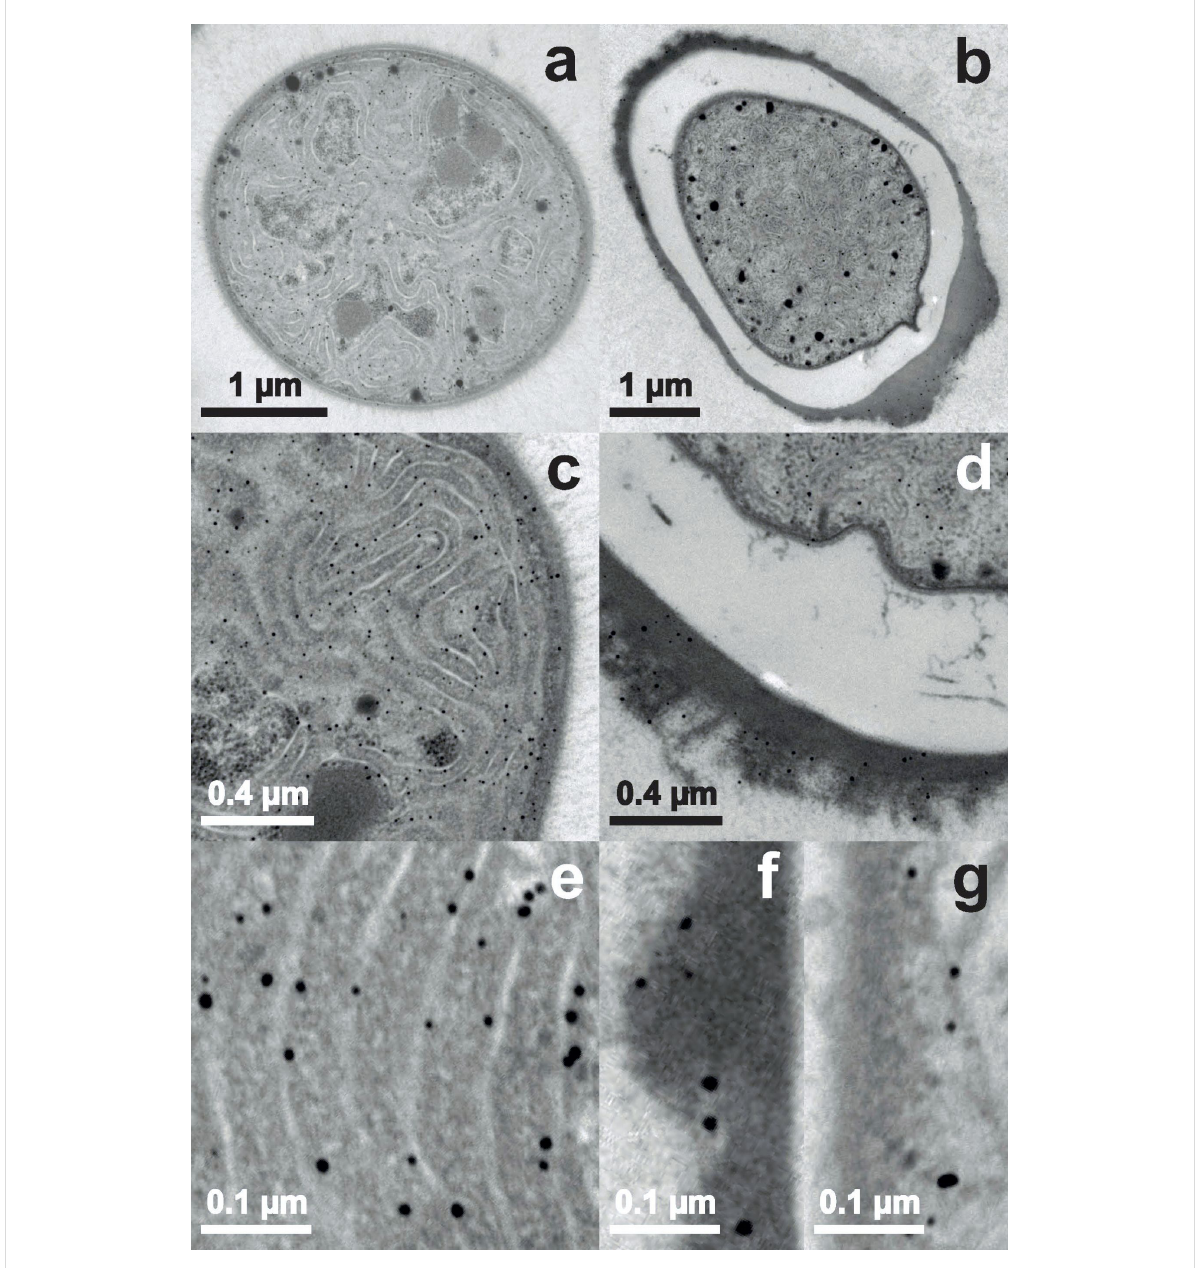
Figure 5: TEM images of Anabaena cylindrica incubated with an overall concentration of 0.8 mM Au 3+ for 25.75 hours. Vegetative cells or parts thereof are displayed in panel (a), (c) and (e), heterocysts or parts thereof in (b), (d), (f) and (g).